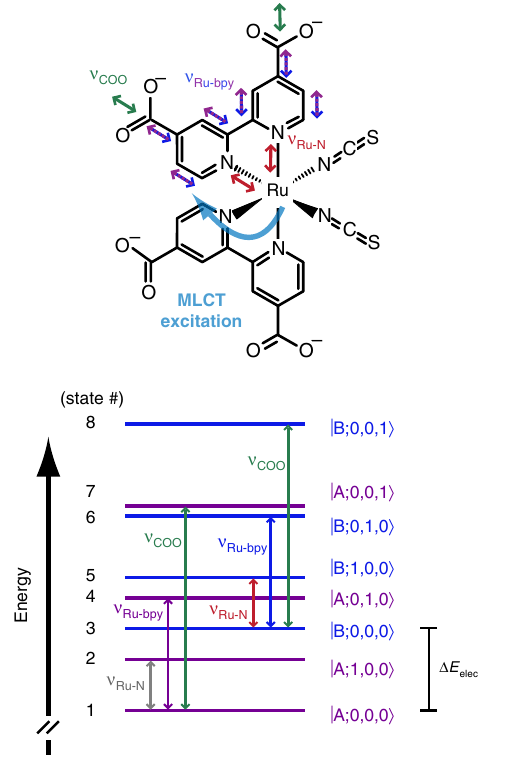
(cid:4) Fig. 3 Vibronic eigenstate basis and energy-level diagram. The measured E (cid:4) ; ν ; ν (cid:4) eigenstate basis of N3 4 − is cast in terms of elec ; ν , Ru (cid:2) N Ru (cid:2) bpy COO where elec = A (MLCT A , purple) or B (MLCT B , blue) and the three following quantum numbers relate the quanta in each of the vibrational modes listed in increasing transition energy. The relative energies are derived from the multidimensional EV measurements: Δ E elec ≅ 500 cm − 1 from ω 1 ; ν Ru-N = 340 cm − 1 and ν Ru-bpy = 742 cm − 1 from ω 2 ; and ν COO = 1328 cm − 1 from ω 3 . The eigenstates are numbered in increasing energy for reference throughout the discussion. The N3 4 − structure (top) schematically depicts the electronic excitation (light blue) and the vibrational motions involved with photoexcited charge transfer. The vibrational mode arrow colors correspond to the respective transitions given in the energy-level diagram below. Vibronic coherence aids nonadiabatic internal conversion . The later time (400 < τ 2 < 1500 fs) dynamics utilize different low- frequency vibrational mode couplings with the vibronic states. The ω 2 ≅ 742 cm − 1 features in Fig. 2d, g demonstrate that ν Ru-bpy has a time-dependent coupling with ν COO and participates in the ρ ν ρ 14 and 36 coherences. The Ru-bpy mode also changes the Ru-N (of dcbpy) distance, emphasizing the importance of this coordi- nate for ultrafast relaxation in N3 4 − . Since the ω 2 spectra (Fig. 2) within the 400 < τ 2 < 1500 fs period, a careful time – frequency analysis 25 (Fig. 5a,b) is used to resolve oscillatory electronic character of the coherences involving ν Ru-bpy . Proper selection of the temporal fi lter used in our analysis is required to extract the transient ν Ru-bpy dynamics and reasonably interpret the result (Supplementary Note 6). Importantly, the ω 2 spectra during the later time period (400 < τ 2 < 1500 fs, Fig. 2d, g) show that the data suf fi ciently resolve only one low-frequency mode coupling: the − 1 which has a vibrational period of 45 fs. ν Ru-bpy mode at 742 cm